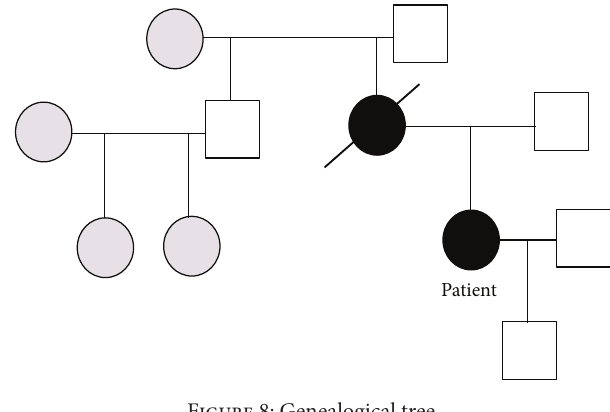
Figure 7: The tumor cells are negative for calretinin. Figure 8: Genealogical